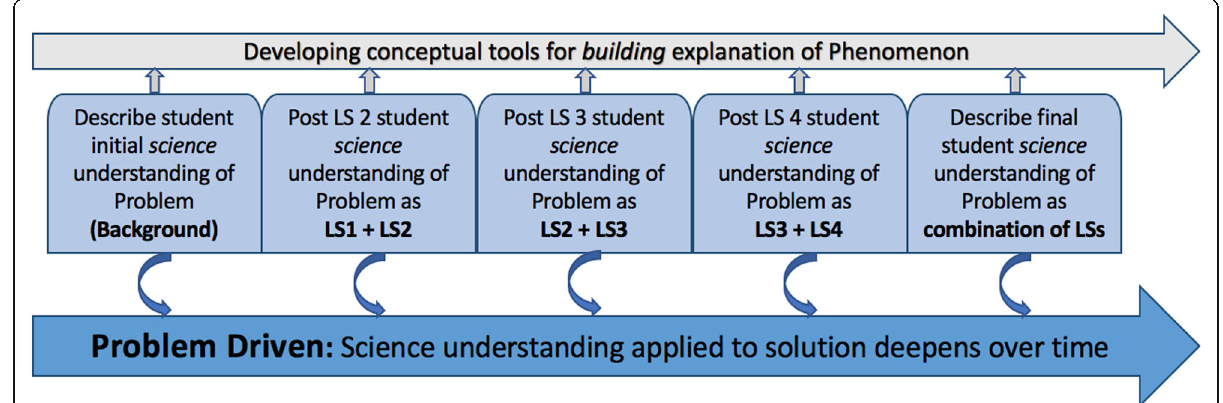
Fig. 2 How application of ideas as conceptual tools is developed and used over time to engage with a solution to a